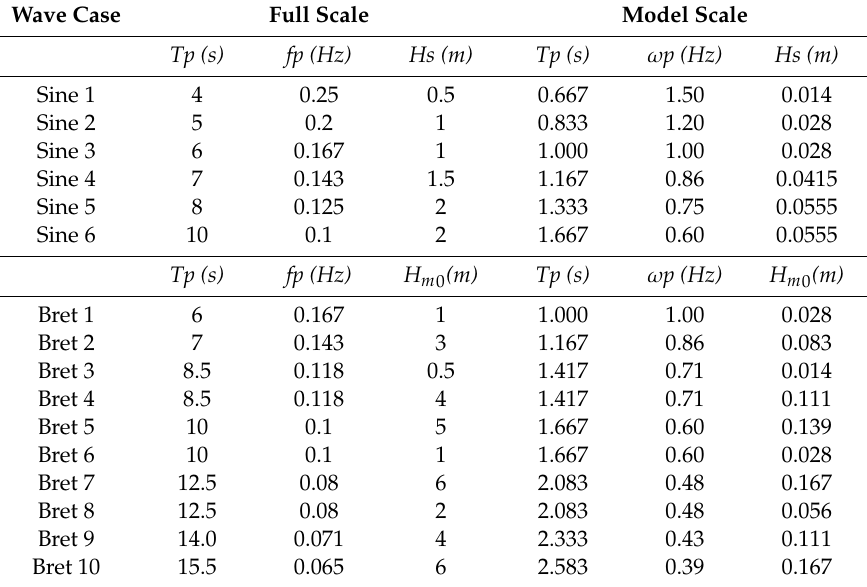
Table 3. Selected wave cases at ocean basin testing model